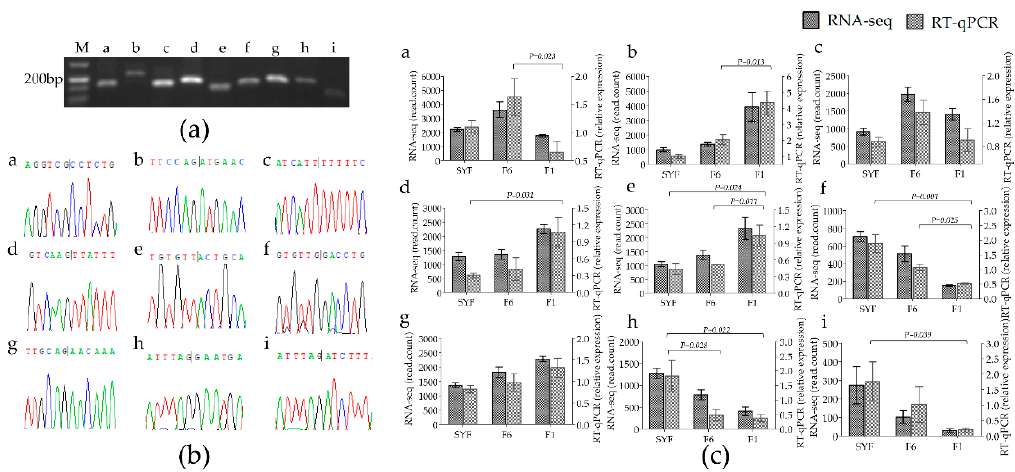
Figure 4. Validation of back-site and RNA-seq of circRNAs: ( a ) divergent primers amplify circRNAs in cDNA. ( b ) Sanger sequencing experimental validation the back-splicing site sequence of circRNA. ( c ) RT-qPCR validation of 9 di ff erentially expressed circRNAs in three groups. SYF: small yellow follicle, F6: smallest hierarchical follicle, F1: largest hierarchical follicle. T: theca cell. Graph numbers of a, b, c, d, e, f, g, h, and i represent circRNAs chr2:75502 | 78826, chr23:5380525 | 5384728, chr4:49990652 | 50010410, chr3:31294378 | 31311114, chr2:47799748 | 47802307, chr3:40478181 | 40486533, chr3:76644181 | 76644976, chr8:6369673 | 6402248, and chr8:6369673 | 6422097, respectively .